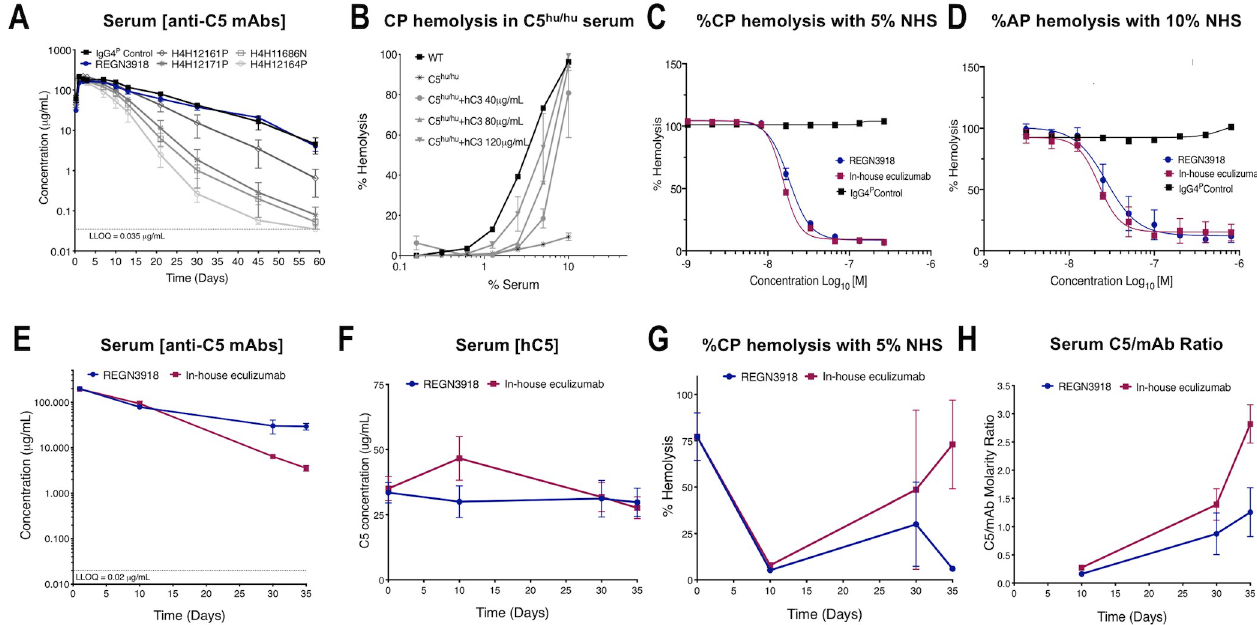
Fig 1. Pharmacokinetic and ex vivo pharmacodynamic properties of anti-C5 antibodies in C5 hu/hu mice. (A) Serum concentrations of antibodies were measured by ELISA at 6 hours, 1, 2, 3, 7, 10, 13, 21, 30, 45 and 59 days post dosing in C5 hu/hu mice administered a single 15 mg/kg subcutaneous dose of anti- C5 mAbs or IgG4 P control antibody (n = 5). REGN3918 is shown in blue. (B) Supplementing serum from C5 hu/hu mouse with recombinant hC3 (40–120 μ g/ mL) restores CP-mediated hemolysis to similar levels observed in serum from WT mice. In all cases, hemolytic activity decreased in a dose-dependent manner relative to the amount of serum used in the assay. Dose response curves from one experiment performed in triplicate, with the exception of wild-type (n = 1), at each serum concentration. Experiment was repeated with multiple sera from different donors (n > 3). (C) SRBCs, sensitized with hemolysin in GVB ++ , were incubated for 60 minutes at 37˚C with normal human serum, resulting in CP-mediated hemolysis. Pre-incubation of serum with increasing concentrations of REGN3918 or in-house eculizumab blocked hemolysis in a dose-dependent manner. (D) RbRBCs in GVB ++ -Mg 2+ /EGTA were incubated for 15 minutes with normal human serum (NHS), resulting in AP-mediated hemolysis. Pre-incubation of serum with increasing concentrations of REGN3918 or in-house eculizumab blocked hemolysis in a dose-dependent manner. For hemolysis assays (C, D), representative experiments are shown that were performed in duplicate at each mAb concentration; each experiment was repeated with multiple sera from different donors (n > 3). (E) Antibody serum concentrations were measured by Gyros from mice at 1, 10, 30 and 35 days post dose in C5 hu/hu mice administered a single 15 mg/kg subcutaneous dose of anti-REGN3918 (blue) or in-house eculizumab (red), n = 4 (E-F). (F) The hC5 serum concentrations were measured and plotted for mice terminally bled at pre-dose and 10, 30 and 35 days post dosing in C5 hu/hu mice administered a single 15 mg/kg subcutaneous dose of anti-REGN3918 (blue) or in-house eculizumab (red). (G) The percent of CP-mediated hemolysis was determined ex vivo using serum from mice terminally bled at predose and 10, 30 and 35 days after administration of REGN3918 (blue) or in-house eculizumab (red). (H) Serum concentrations of hC5 and hIgG were used to calculate the serum C5/mAb ratio in C5 hu/hu mice dosed with anti-REGN3918 (blue) or in-house eculizumab (red). Data is plotted as mean ± SEM (A-F).